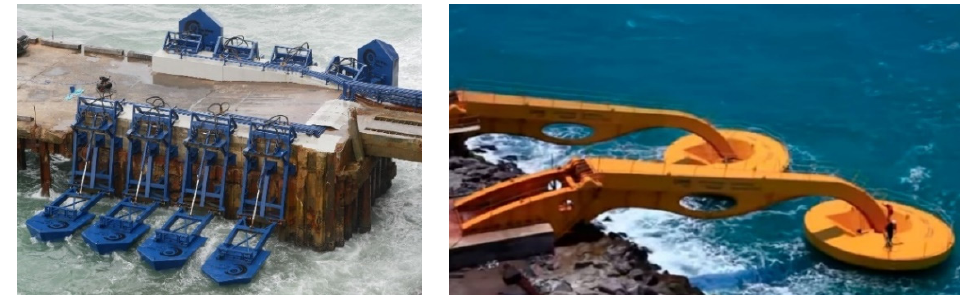
Figure 27. Rendering view of Wavestar [91,92].